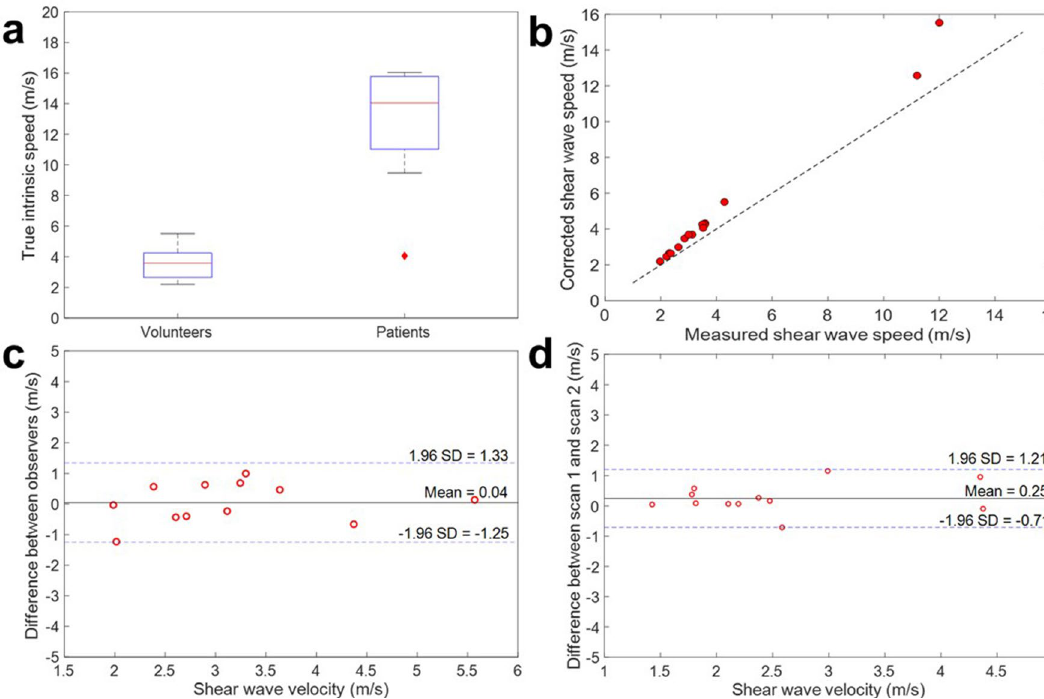
Figure 8. Application to healthy volunteers and cardiac patients. (a) Boxplot of true intrinsic wave speed obtained using the time-of-flight method in volunteers (left) and patients (right), indicating significant differences. The patient screened for but ultimately without cardiovascular pathology (red diamond) shows a speed in the range of the healthy volunteers. (b) Plot showing measured compared to shear wave velocity after correcting for bias caused by wall thickness for each participant. ( c) Bland Altman plot for inter-observer variability between two operators. The mean difference between observer A and observer B was 0.04 m/s and 95% limits of agreement were − 1.25 and 1.33 m/s. Note that even with this variability, the difference in shear wave speed between volunteers and patients remains statistically significant. ( c) Bland–Altman plot for interstudy variability between two scans. The mean difference between scan 1 and scan 2 for each individual was 0.25 m/s and 95% limits of agreement were – 0.71 and 1.21